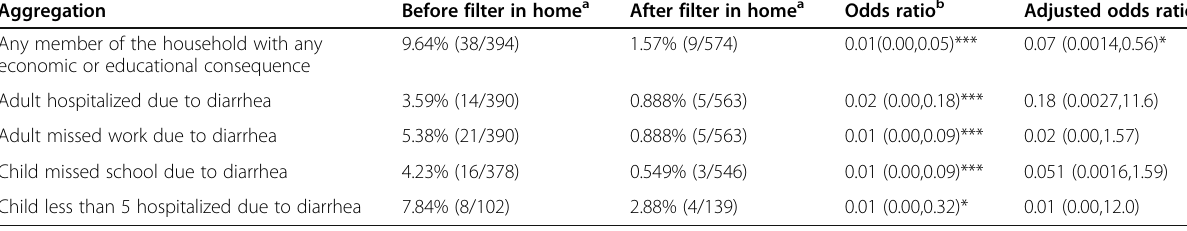
Table 5 Prevalence of diarrhea with economic or educational consequence by home filter status Aggregation Before filter in home a After filter in home a Odds ratio